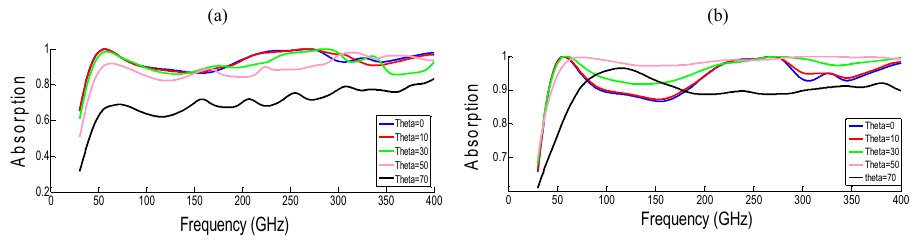
Figure 8. The absorption is based on oblique incidence (theta) ( a ) TE mode ( b ) TM mode.